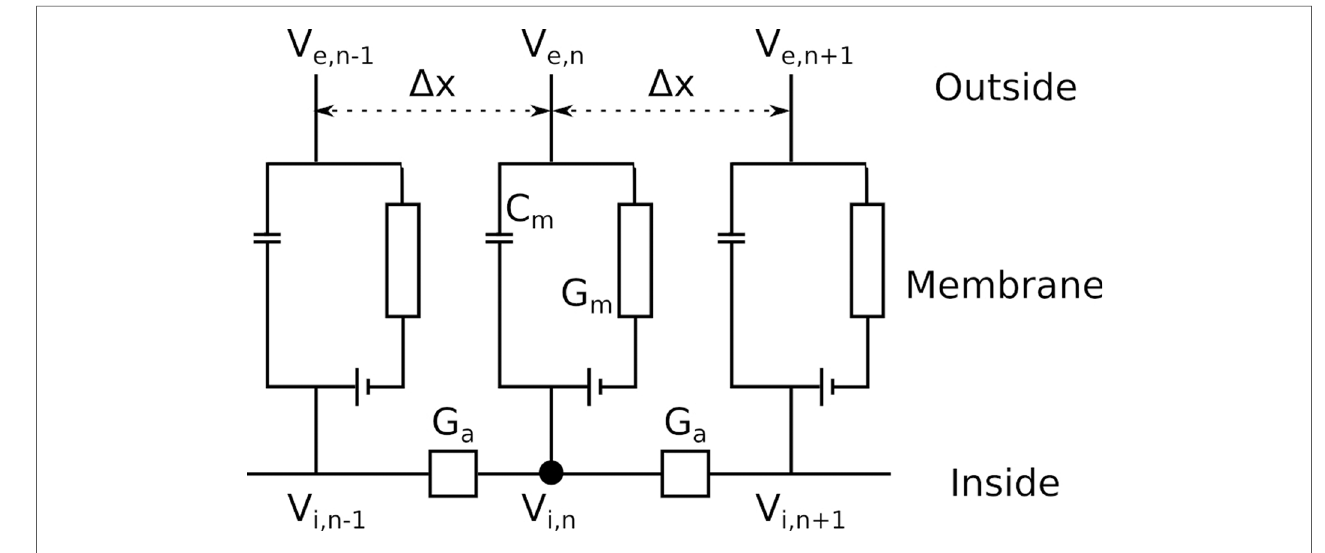
FIGURE 14 Electrical network representation of axon